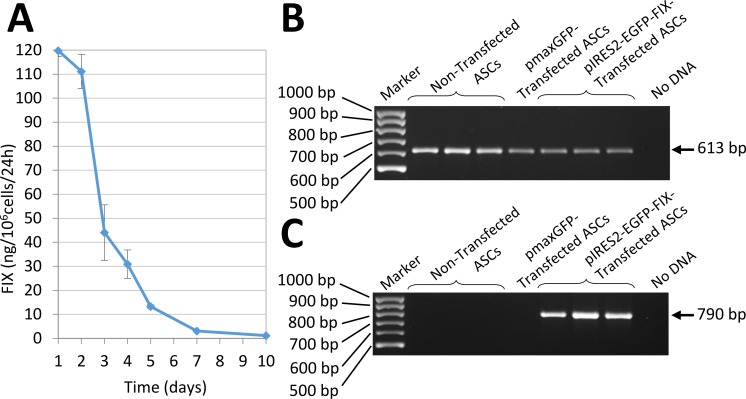
Human FIX expression by nucleofected ASCs.(A) Evolution of human FIX levels in ASC culture media after nucleofection as determined by ELISA over a 10-day period. Results shown correspond to transfected cells from the donor that secreted the largest amount of FIX. (B) RT-PCR analysis showing human β-actin expression, used as a control. Bands are observed in both transfected and non-transfected cells, as expected. (C) Expression of human factor IX is detected in cells nucleofected using pIRES2-EGFP-FIX plasmid but remains undetectable both in non-transfected cells and in pmaxGFP™ transfected cells.